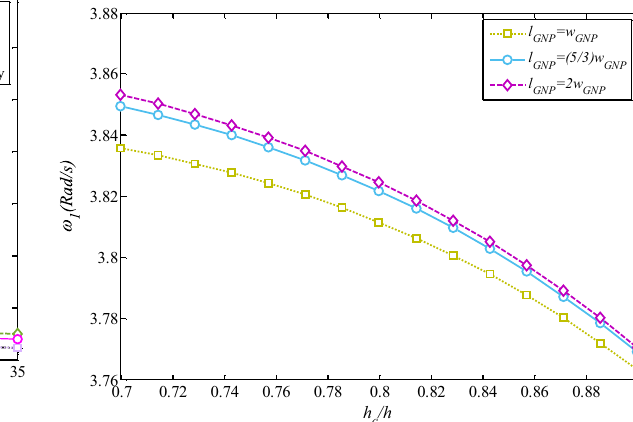
Figure 5: GNPs dispersion patterns ’ e ff ect on the natural frequencies ( h = 0.01 m , h = 10 h R = 100 h , φ = 2 π ) . c f , r